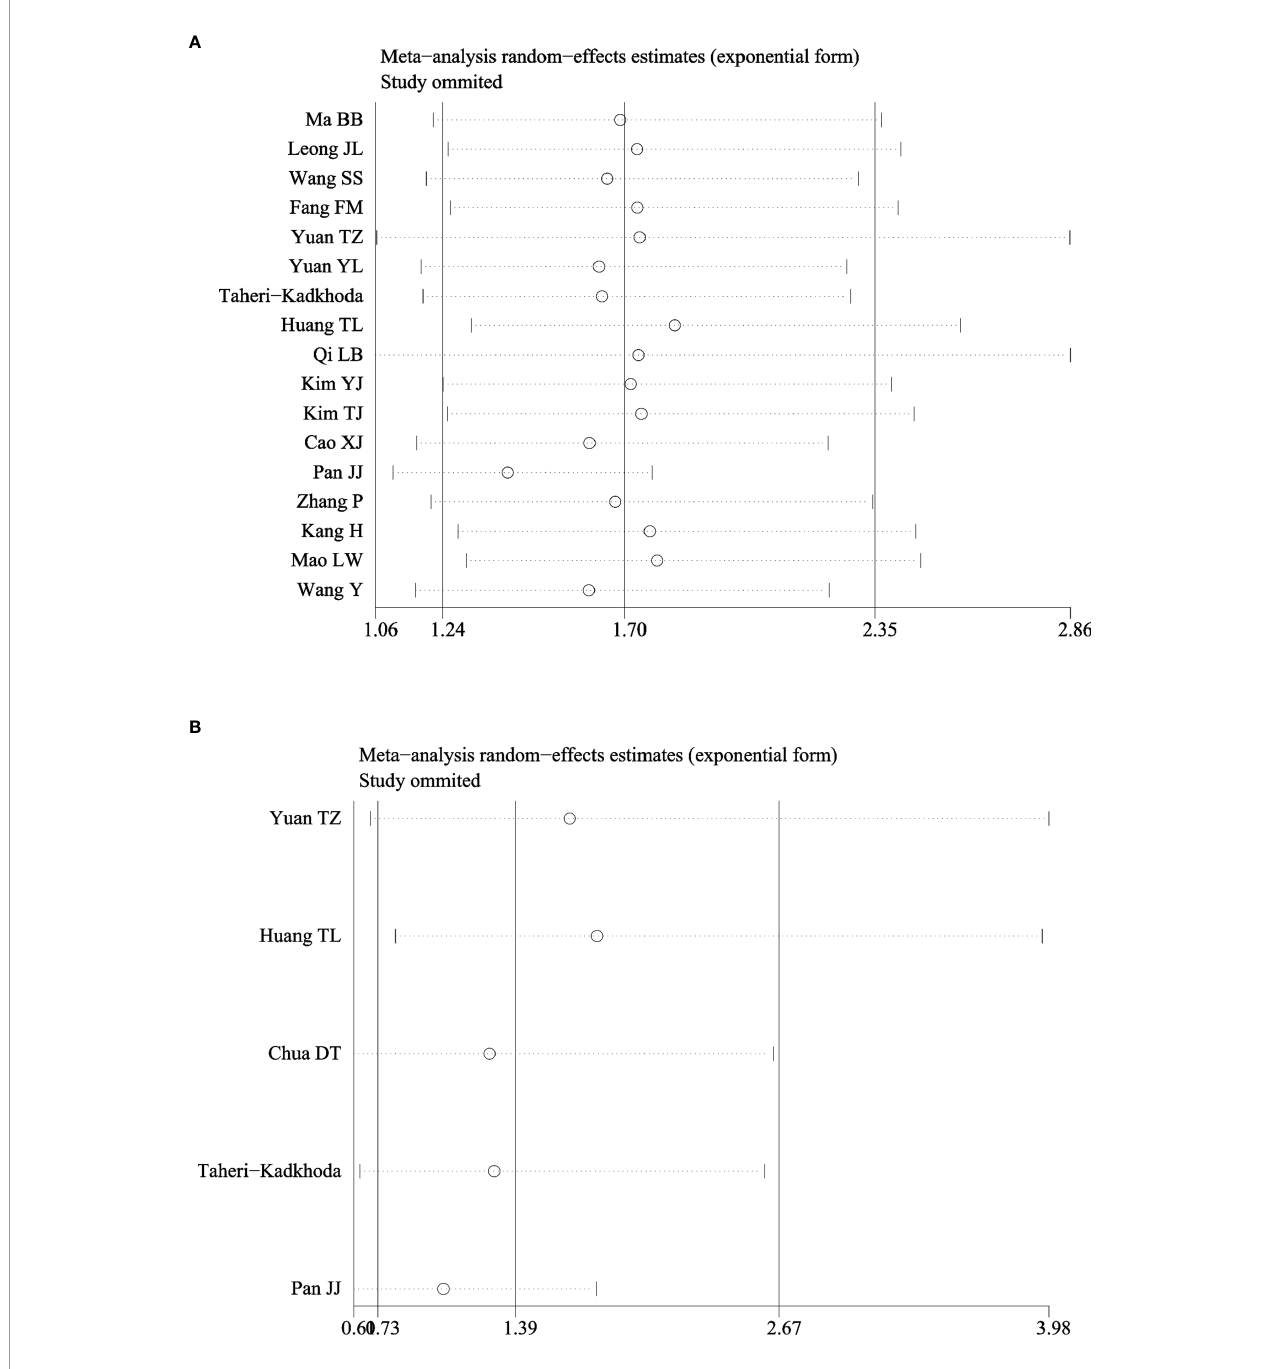
FIGURE 4 | Sensitivity analysis of hazard ratios of EGFR for OS and DMFS. (A) EGFR and OS. (B) EGFR and